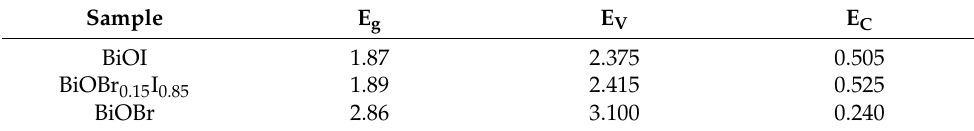
Table 3. Band structure parameters of samples (unit: